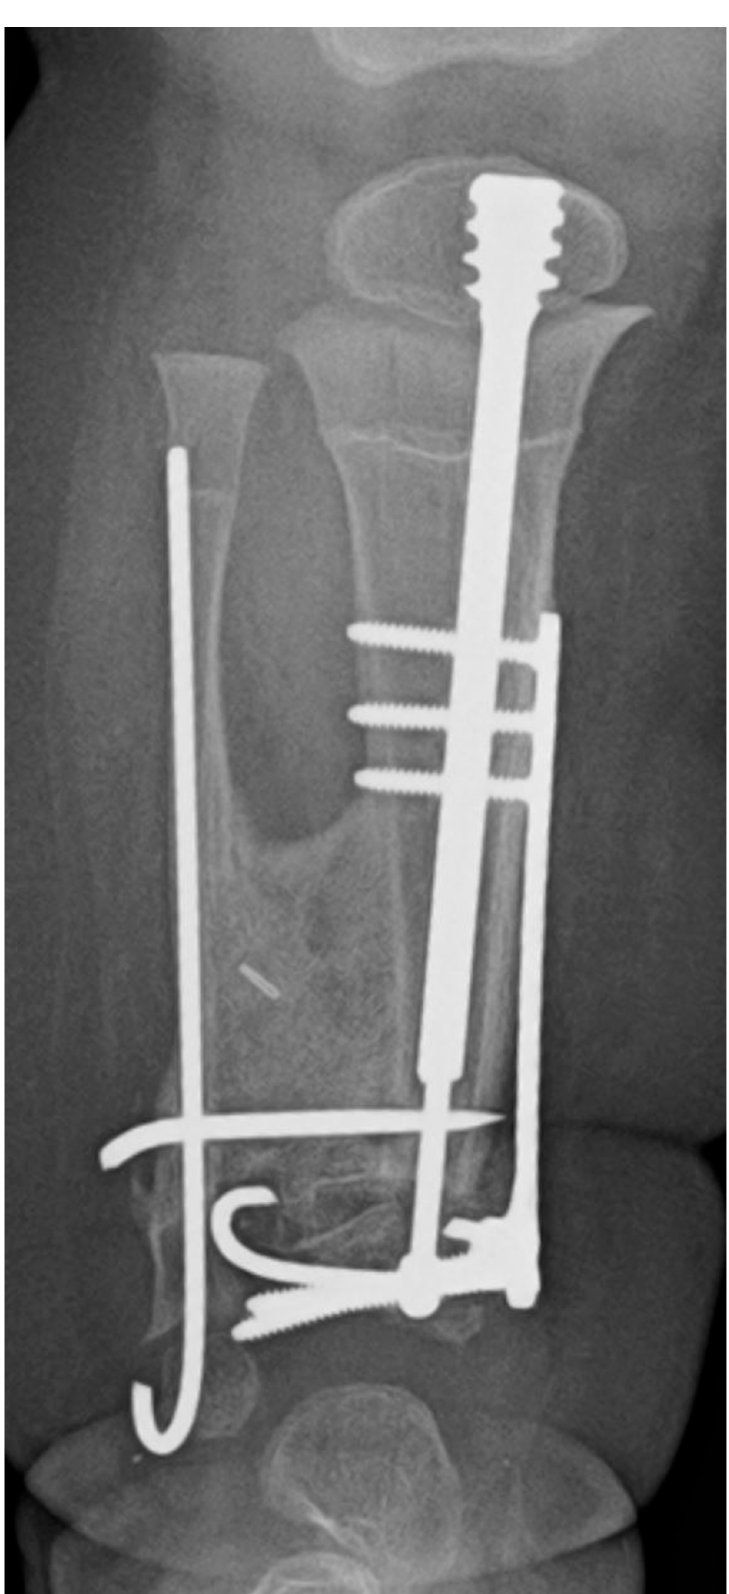
Figure 6. AP radiograph showing an example of a very distal pseudarthrosis site. This required fixation into the distal tibial epiphysis as there was not enough distal tibial metaphysis for screw placement. The cross-union is fully healed, and these screws can now be removed to allow the physis to resume growth.